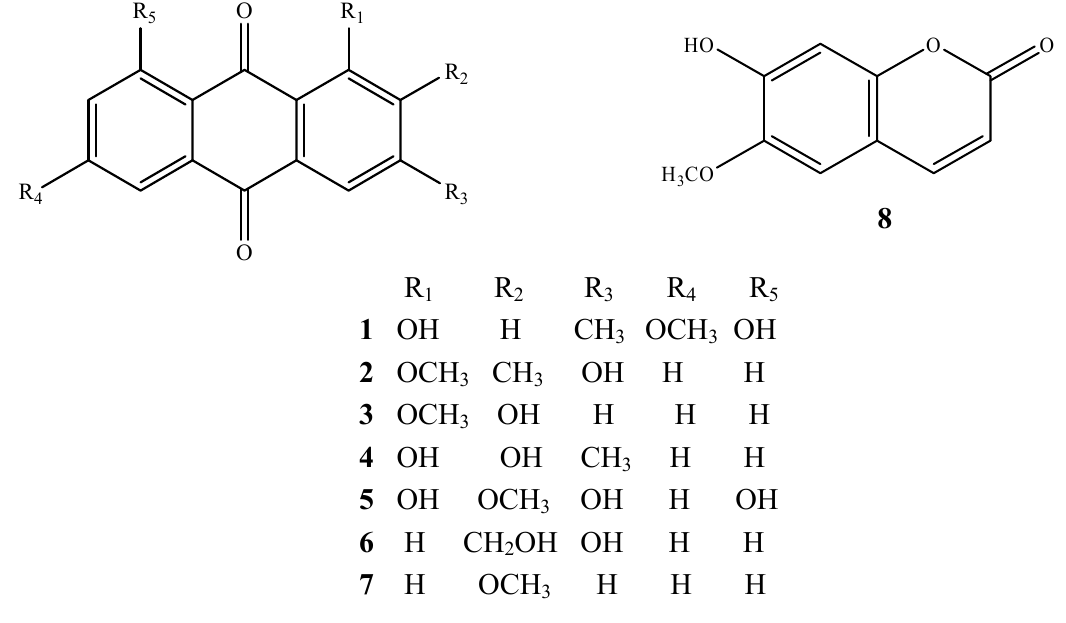
Figure 1. Structures of compounds 1-8 isolated from root of Morinda